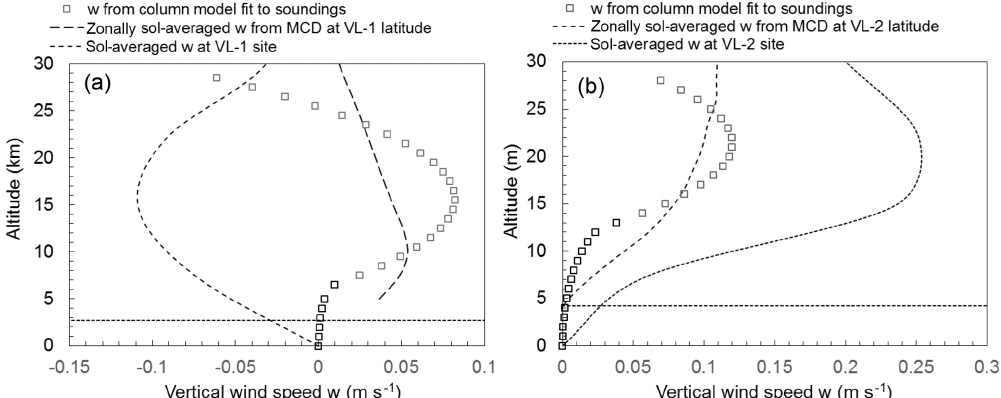
Figure 9. Comparison of the derived vertical wind speed (positive downward) from the model against the average zonal and sol-averaged vertical wind speeds from the MCD for the VL-1 and VL-2 sites at L S 270 ◦